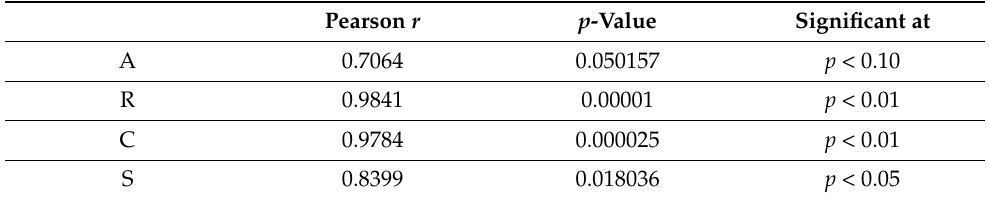
Table 5. Pearson r for ARCS before and after training for each factor of the ARCS model (Attention, Relevance, Confidence, Satisfaction).